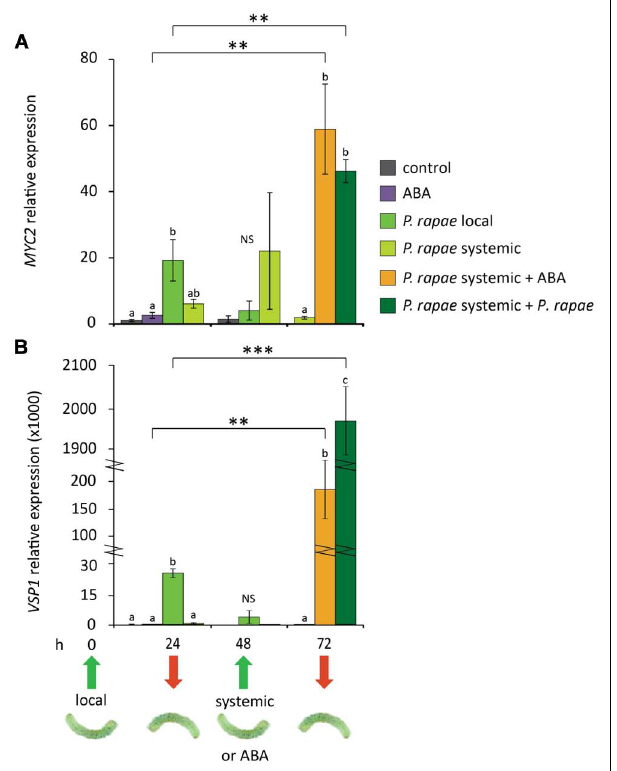
FIGURE 3 | Effects of P. rapae feeding andABA treatment on expression of the MYC-branch in undamaged leaves of pre-infested Col-0 plants. RT-qPCR analysis of (A) MYC2 and (B) VSP1 transcript levels (relative to non-infested control at 24 h) in P. rapae -infested Col-0 plants. First-instar larvae were allowed to feed for 24 h after which they were removed ( t = 24 h). Damaged ( P. rapae local) and undamaged ( P. rapae systemic) leaves were harvested for analysis at different time points after removal of the P. rapae larvae. In addition, at t = 48 h, undamaged systemic leaves were challenged with fresh first-instar larvae or treated with 10 μ M ABA.Treated systemic leaf tissue was harvested 24 h later ( t = 72 h) for gene expression analysis. For comparison, non-infested plants received ABA treatment as well. Depicted are the average expression levels ( ± SE) of three biological replicates, consisting of five leaves each. Different letters indicate statistically significant differences between treatments at specific time points (ANOVA,Tukey post hoc test; P < 0.05; NS, not significant). Asterisks indicate statistically significant differences between (ABA or P. rapae )-treated leaves treatment of undamaged ( P. rapae systemic) leaves of P. rapae -infested plants and the same treatment of leaves of non-preinfested plants (Student’s t -test; ** P < 0.01; *** P < 0.001).